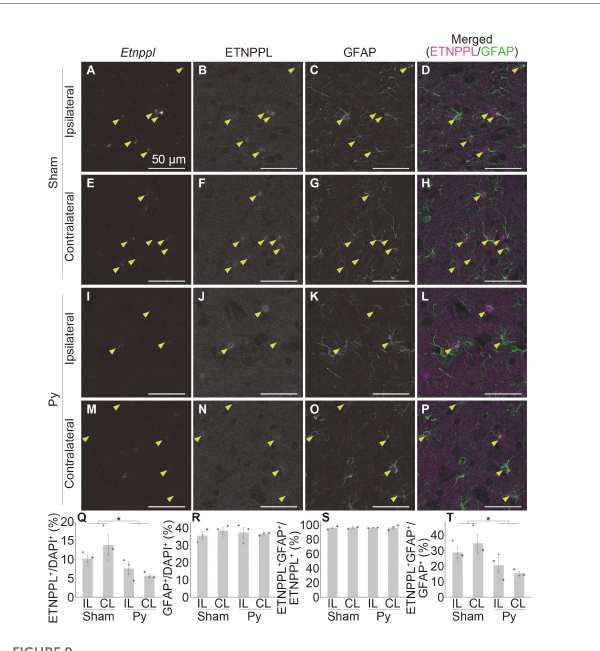
FIGURE9 Astrocytic response after pyramidotomy revealed by IHC using anti ETNPPL monoclonal antibody. (A–P) Representative confocal images of the ipsilateral (A–D,I–L) or contralateral side (E–H,M–P) of the gray matter of the cervical cord of 8 W female mice 3 days after sham surgery (A–H) or pyramidotomy (I–P) . Signals for Etnppl mRNA (RNAscope; A,E,I,M ), ETNPPL protein (B,F,J,N) , and the retrieved GFAP protein (C,G,K,O) are shown. In merged images (D,H,L,P) , magenta indicates the signal for ETNPPL protein and green indicates the signal for GFAP. Yellow arrowheads indicate double-positive cells for ETNPPL protein and GFAP. (Q–T) Quantification of changes in ETNPPL-expressing cells after pyramidotomy. Vertical axes represent the percentage of ETNPPL + cells to total cells (Q) , GFAP + astrocytes to total cells (R) , ETNPPL + GFAP + cells to total ETNPPL + cells (S) , or ETNPPL + GFAP + cells to total GFAP + astrocytes (T) . Mean ± S. E. M. n = 3 individuals, each of which is the average of four different sections. * P < 0.05, Sham vs. Py, two-way ANOVA. The same color indicates the same individual. IL, ipsilateral; CL,